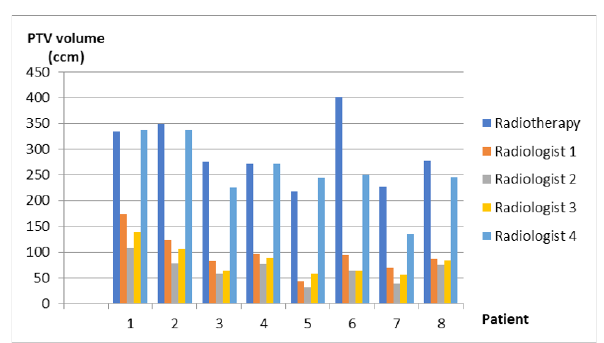
Fig. 1. Volumes of planning target volumes (PTV) in all 8 pa- tients defined per protocol by radiation oncologist and by the estimate of four